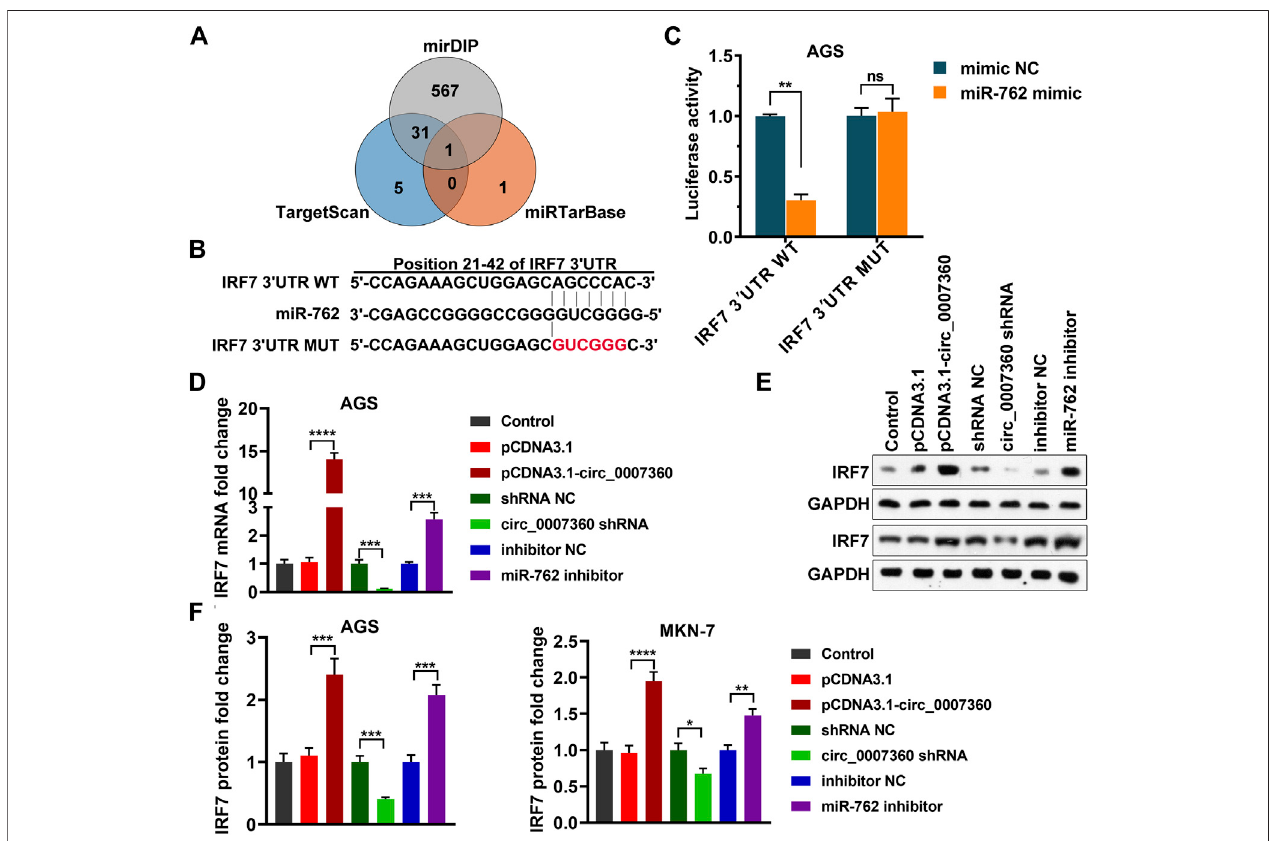
FIGURE 7 | IRF7 is a target mRNA of miR-762 . (A) Venn diagram indicating the intersection between three databases for predicting the target genes of miR-762 . (B) Schematic plot showing the interacting site between the wild type (WT) or mutant (MUT) IRF7 3 ′ UTR and miR-762 . (C) The relative luciferase activity of WT or MUT IRF7 3 ′ UTR in the presence or absence of miR-762 mimic. (D , E) RT-qPCR (D) or western blotting (E) quanti fi cation of IRF7 expression in AGS cells with ectopic expression of circ0007360 , knockdown of circ0007360, or miR-762 . (F) Quanti fi cation of IRF7 protein levels in AGS or MKN-7 cells with ectopic expression of circ0007360 , knockdown of circ0007360, or miR-762 .